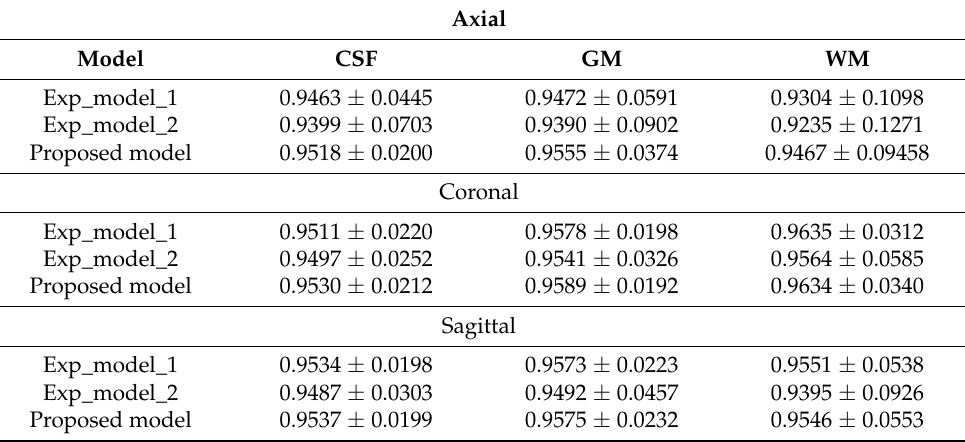
Table 2. DSC score comparison of segmentation results of all testing subjects (average of DSC scores in total testing